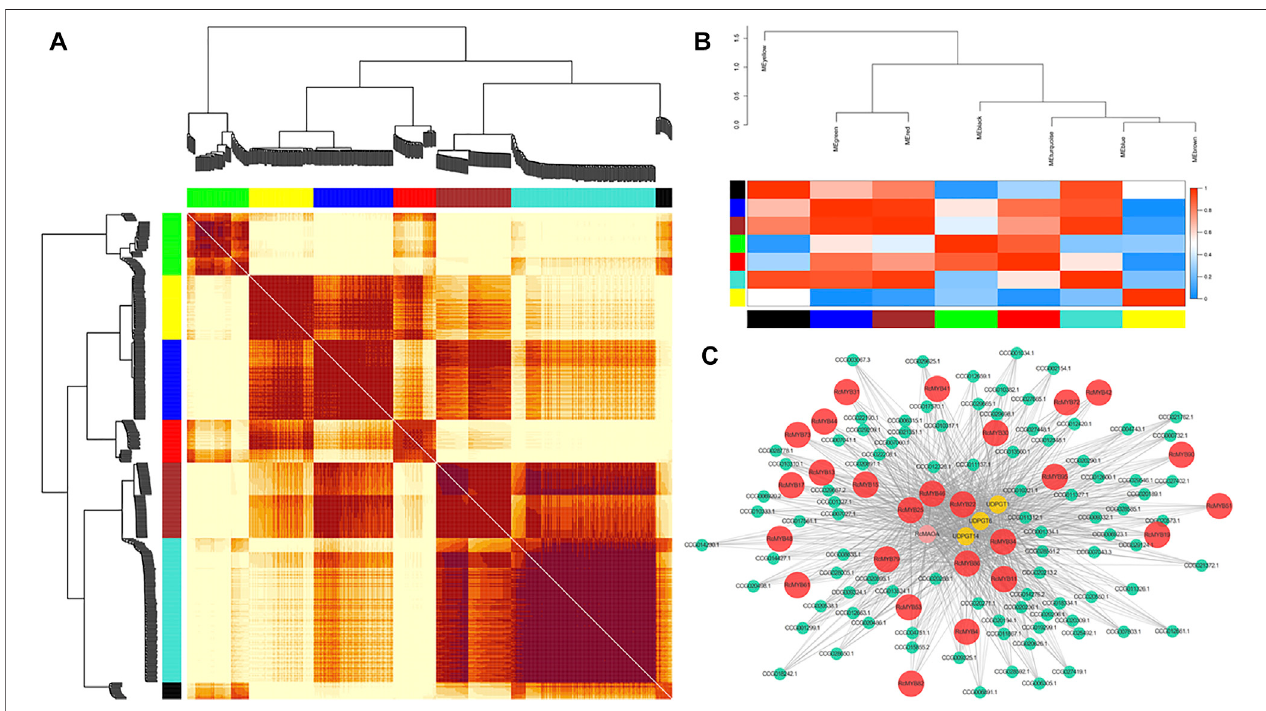
FIGURE 5 | Co-expression network of RcMYB genes in R. crenulata . (A) The heatmap of correlation degree of modules. (B) Clustering of modules based on eigengenes. The colors ranging from blue to red represent Pearson correlation coef fi cients ranging from 0 to 1, indicating low to high correlations, respectively. (C) Visualization of connections of genes in the turquoise module. The RcMYB genes are colored in red. Connections of genes in other modules are shown in Supplementary Figure S6